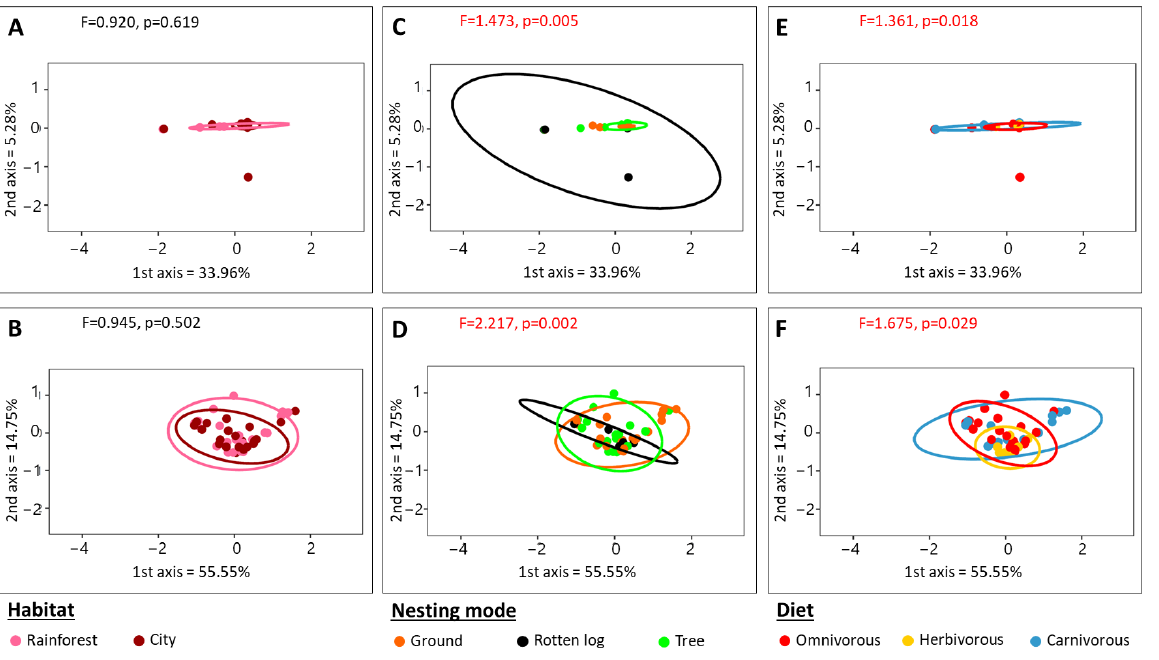
Figure 2. Differences in bacterial communities visualized with PCoAs across ant habitats ( A , B ), nesting modes ( C , D ), and diets ( E , F ). The distances used were the Bray–Curtis ( A , C , E ) and wUniFrac ( B , D , F ). The statistical p -values were obtained with pairwise PERMANOVAs. The circles represent confidence intervals of 0.95.